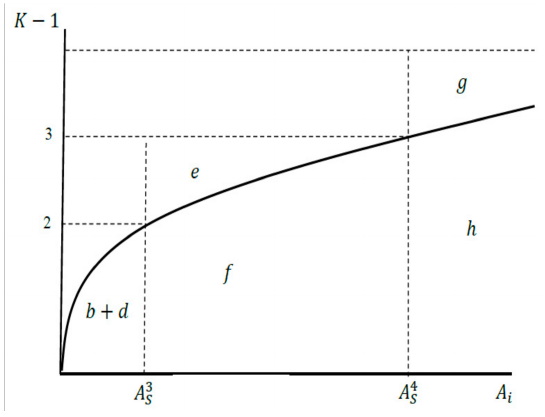
Figure 1. Benefits from entering a coalition if α = 1.